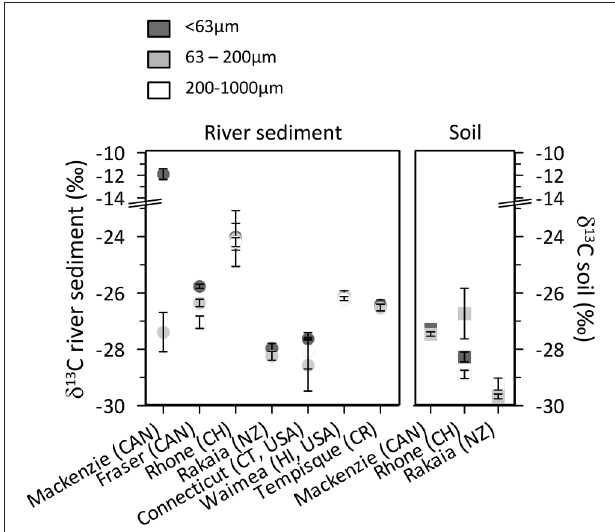
FIGURE 3 | Bulk δ 13 C values of particle size fractions of riverbank sediments (left panel) and soils (right panel). Error bars represent the variation of triplicate sample